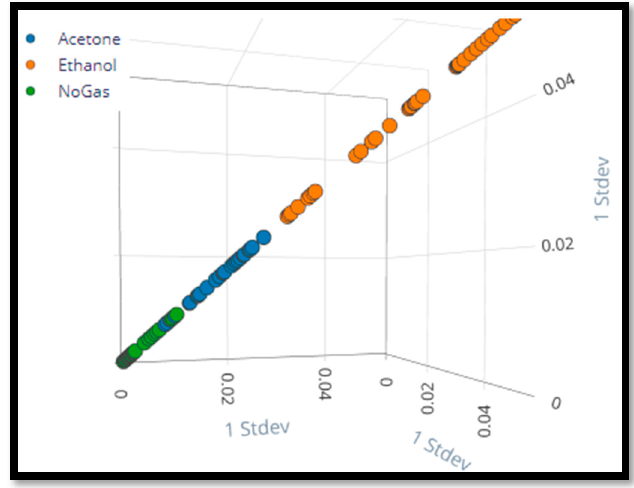
Figure 5. Standard deviation feature on a minibatch. Good separation was achieved (little overlap between Acetone and ‘No Gas’ classes).